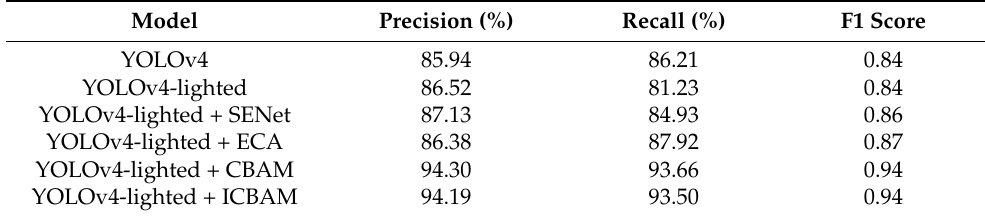
Table 4. Performance of six tea bud detection models.